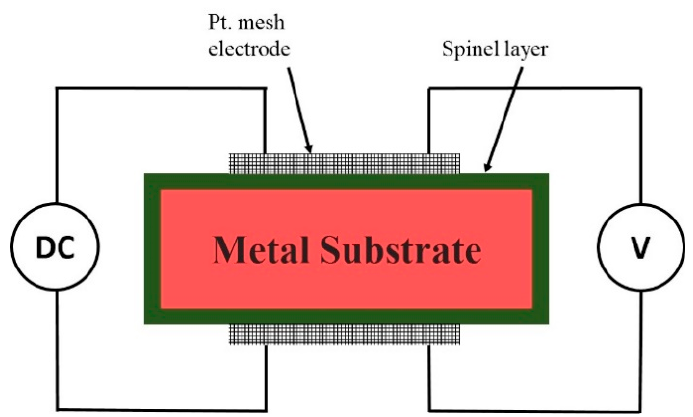
Figure 4. Schematic diagram area-specific resistance (ASR) setup.